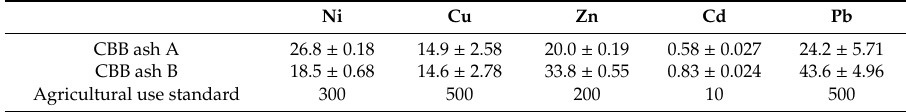
Table 10. Heavy metal concentrations [mg / kg] in CBB ash A and B and agricultural use